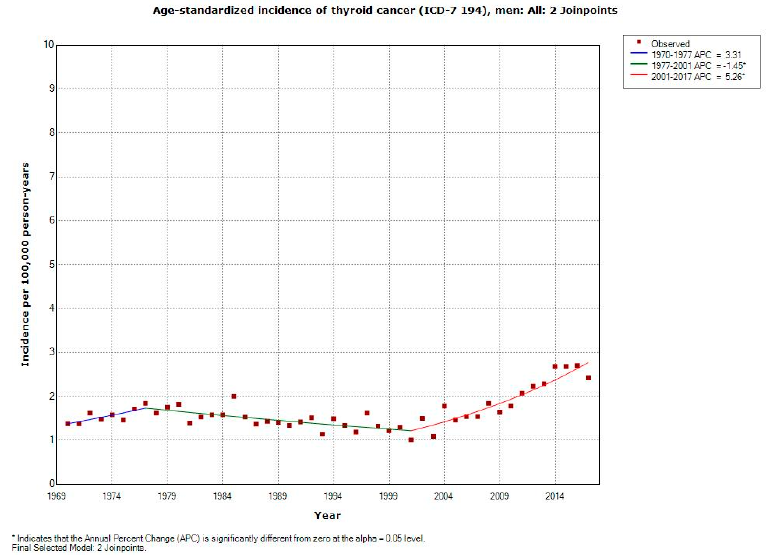
Figure 2. Joinpoint regression analysis of age-standardized incidence of thyroid cancer for men, all ages 1970–2017. Incidence per 100,000 inhabitants for ICD-7 code 194 according to the Swedish Cancer Register (https://sdb.socialstyrelsen.se/if_can/val.aspx). Table 1. Joinpoint regression analysis of thyroid cancer incidence in women in the Swedish Cancer Register 1970–2017. ICD-7 code 194 (https://sdb.socialstyrelsen.se/if_can/val.aspx). APC = Annual Percentage Change (APC 1 = time from 1970 to first joinpoint; APC 2 = time from first joinpoint to 2017 or to second joinpoint; APC 3 = time from second joinpoint to 2017 or to third joinpoint; APC 4 = time from third joinpoint to 2017); AAPC = Average Annual Percentage Change.